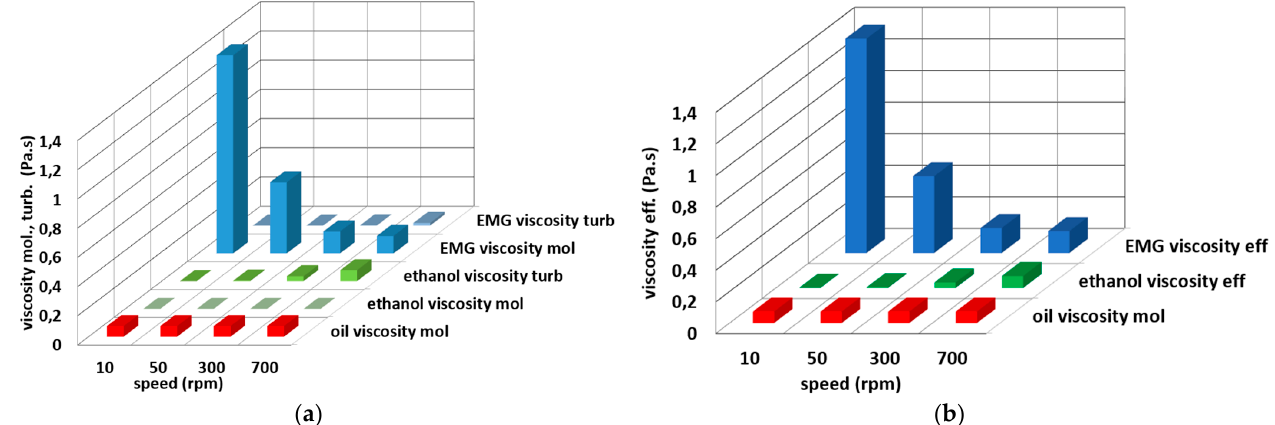
Figure 11. Computed mean viscosities: molecular, turbulent and effective. The strain rate increases for all the fluid variants; see Figure 12.